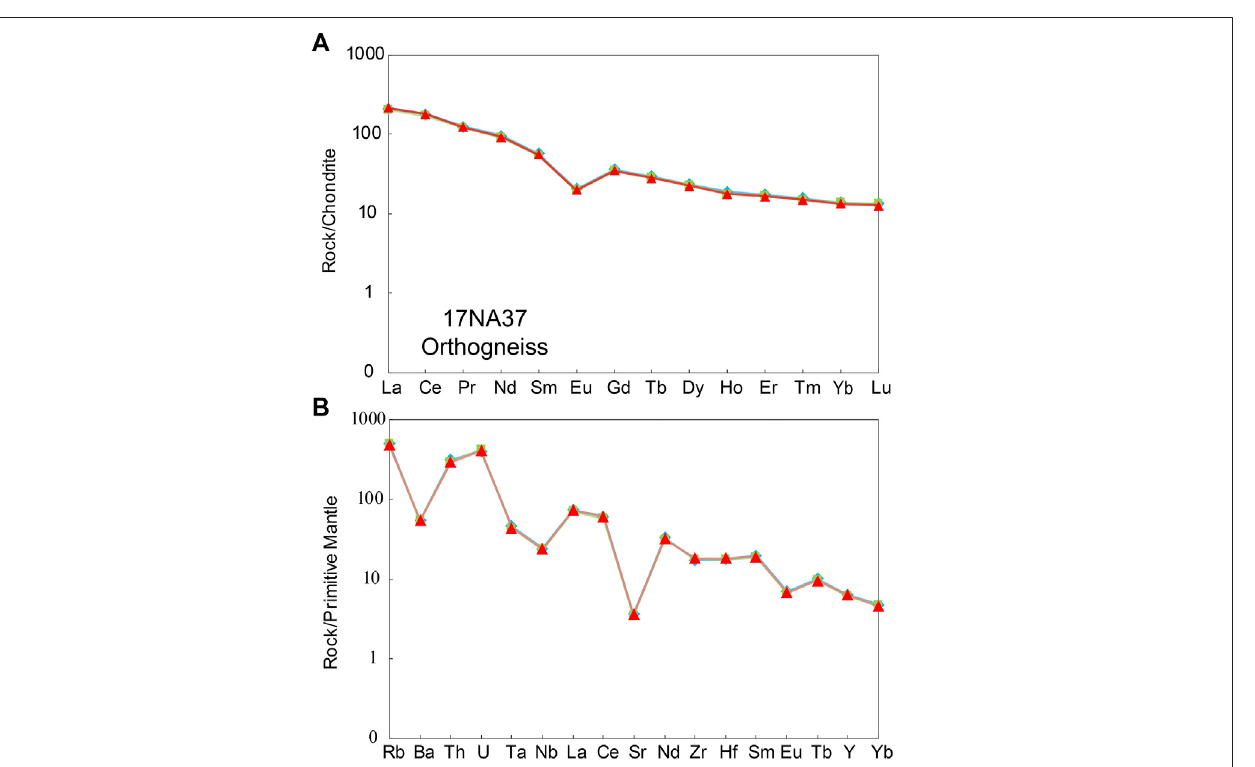
FIGURE 11 | (A) Chondrite-normalized rare Earth element (REE) patterns for orthogneiss. (B) Primitive mantle-normalized trace element variation diagrams. Normalization factors are from the study by Sun and McDonough (1989).